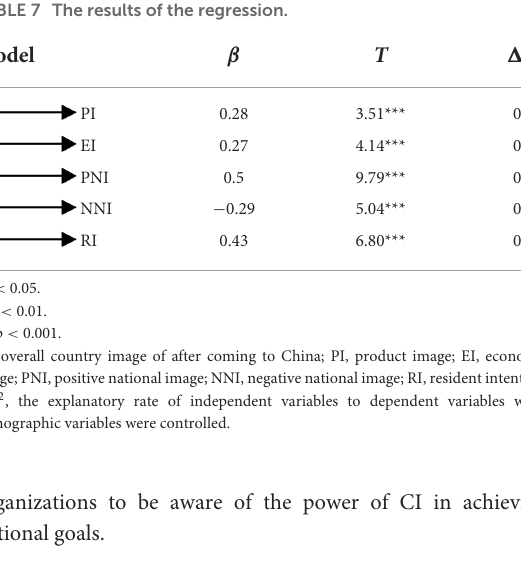
BGI,governmentimageofbeforecomingtoChina;BSI,socialimageofbeforecomingtoChina;BII–internationalimageofbeforecomingtoChina;BAC,affectivecomponentofcountry image before coming to China; AGI, government image of after coming to China; ASI, social image of after coming to China; AII, international image of after coming to China; AAC, affective component of country image before after coming to China; BCI, overall country image of before coming to China; ACI, overall country image of after coming to China; PNI, positivenationalimage;NNI,negativenationalimage;EI,economicimage;PI,productimage.